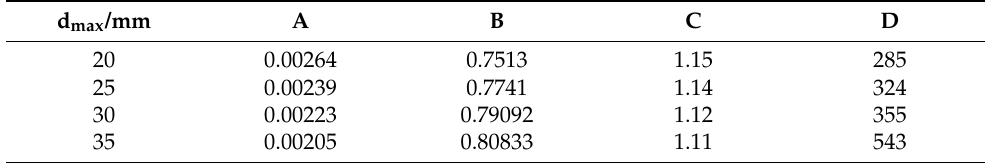
Table 7. Theoretical parameters of the Bažant size effect law.